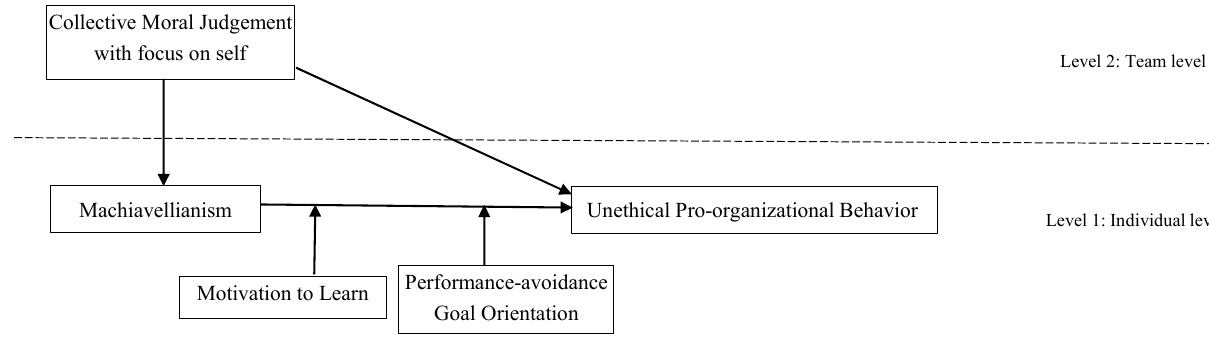
Figure 1. The conceptual model of the research.